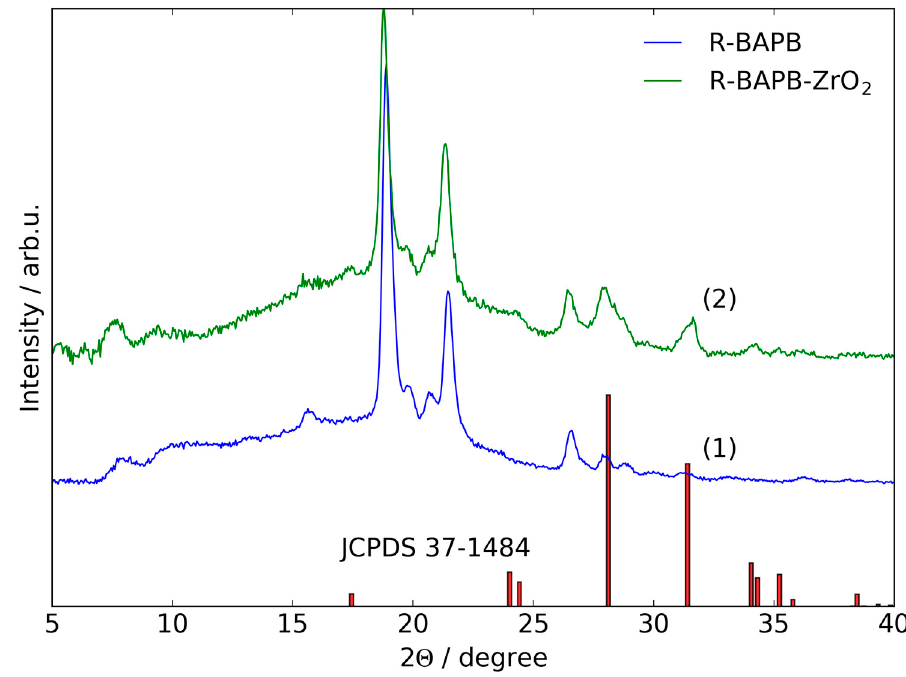
Figure 3. The wide-angle X-ray diffraction (WAXD) patterns of pristine polyimide (R-BAPB) ( 1 ), its composite with zirconia (R-BAPB-ZrO 2 ) ( 2 ) and reference pattern for monoclinic zirconia (JCPDS 37-1484).